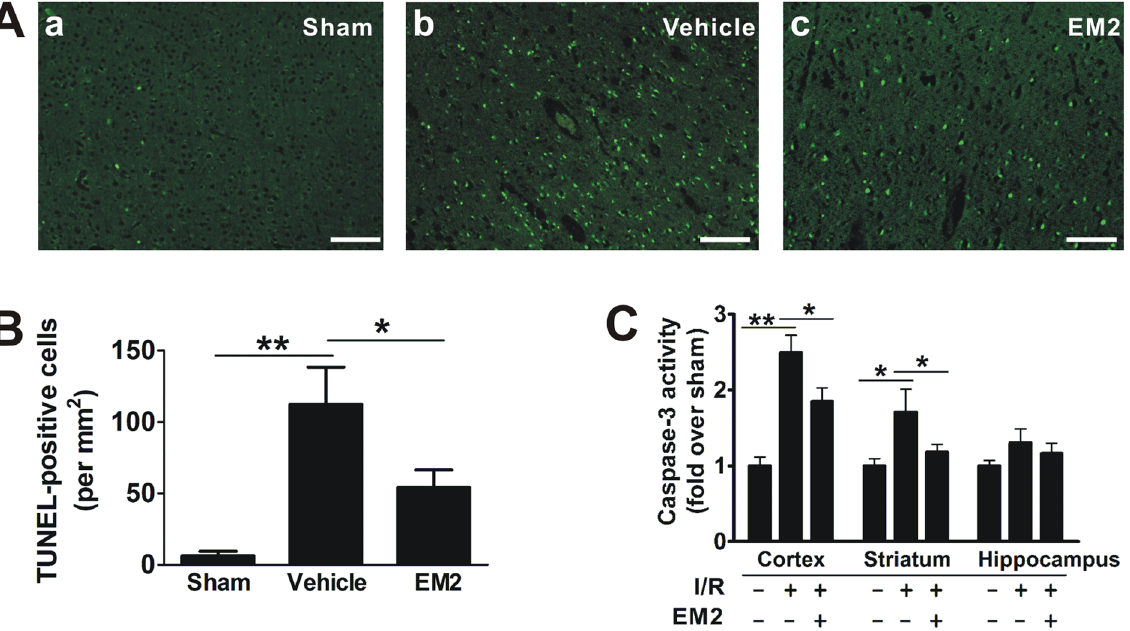
Figure 4. EM2 reduces ischemia-induced neuronal cell apoptosis and caspase-3 activation. ( A ) Representative photographs show TUNEL staining cells within the cortical ischemic penumbra area. ( B ) Quantification of the number of TUNEL-positive cells shown in A (n = 3). ( C ) Colorimetric detection of caspase-3 activity in different regions of brain (n = 3). All data are means ± S.E.M. * p < 0.05, ** p < 0.01 compared with indicated group. Scale bar = 100 μ m.